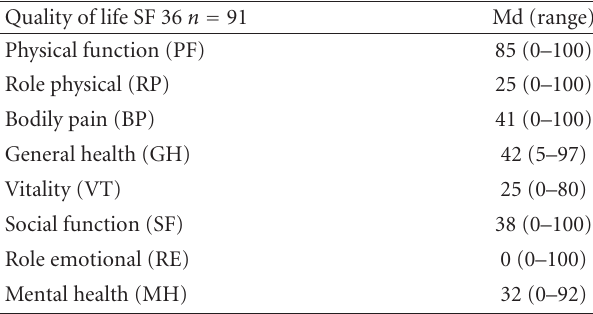
Table 4: Quality of life according to SF 36 ( n = 91).